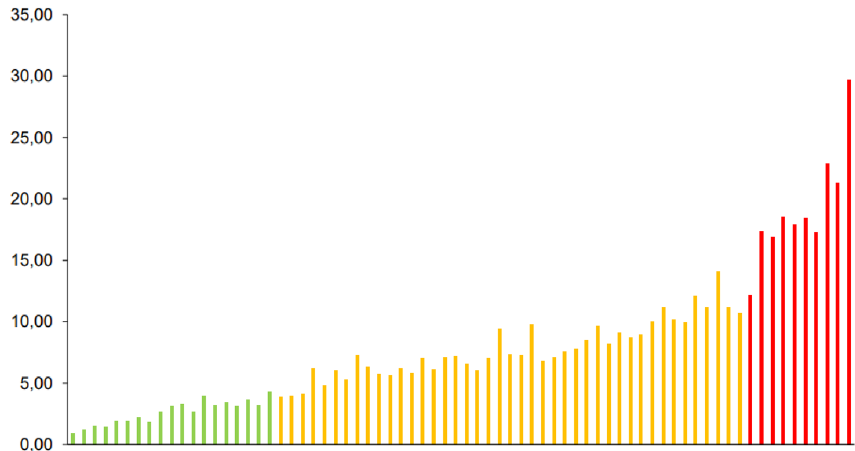
Figure 2. Distribution of 72 ½ Angus × ½ Nellore heifers based on tick counts. Green, yellow and red bars means resistant, resilient and susceptible animals,